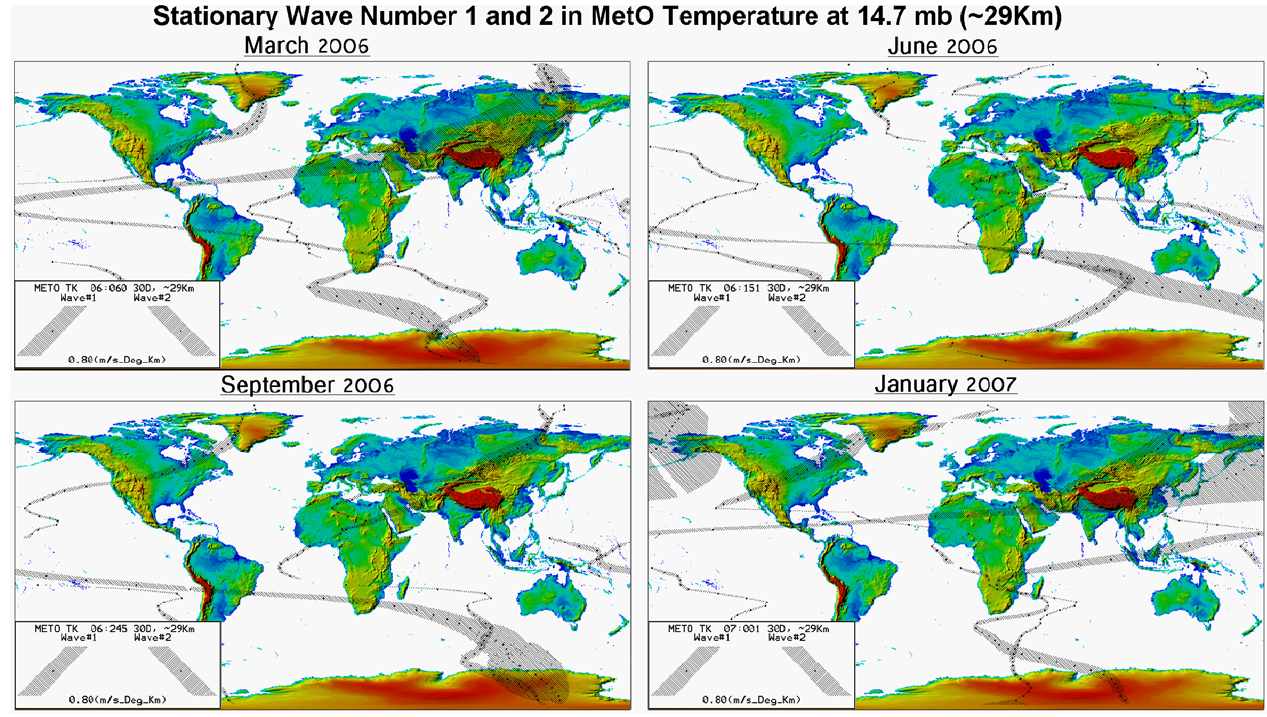
Fig. 11. Topographical global map: grey is sea level, and the Himalayas are 10km (USGS). The 29km atmospheric temperatures from MetO for the 4 seasons of the year provide pole to pole amplitudes of SPW S =1 and 2. The width of the hatched area perpendicular to the orientation of the line(s) of maximum temperature shows the amplitude of zonal stationary planetary waves S =1 and 2 in MetO-temperature. The hatch-widths given in the bottom left corner of each panel show the amplitude scale. Here the shown hatch-widths represent 0.8 degrees (K). The two slants of hatching are for S =1 (NW-SE) and 2 (SW-NE), and both positions of maxima are shown for S